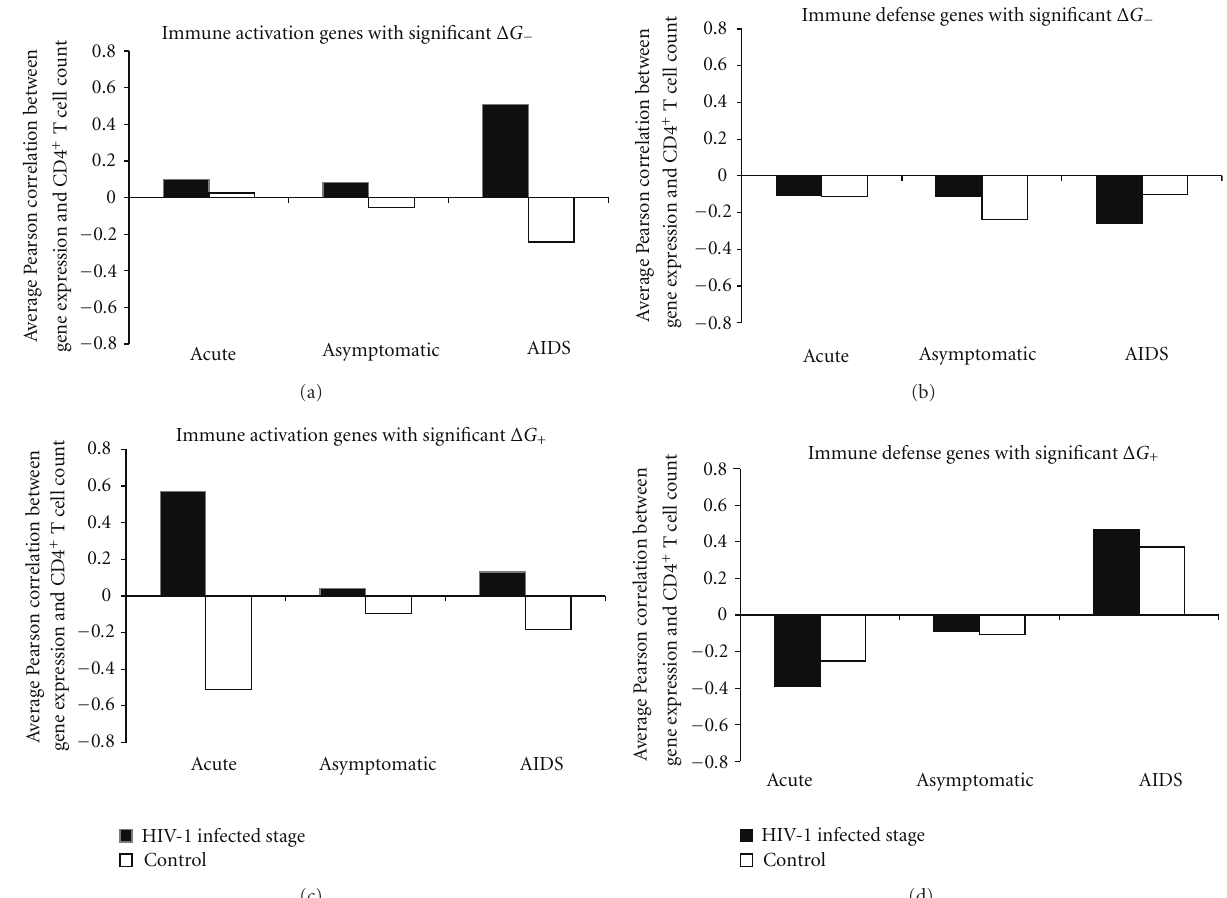
Figure 6: Average Pearson correlation between gene expression and CD4+ T cell count. “HIV-1 infected stage” indicates immune activation (or defense) genes at the HIV-1 infected stages (i.e., the acute, the asymptomatic and the AIDS stage). “Control” represents the corresponding immune genes in the HIV-1-uninfected